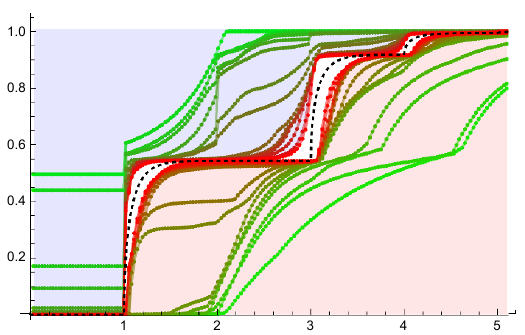
Figure 8 . Bounds on the modular spectral function with no scalar primaries in the spectrum and a dimension gap of (cid:1) gap = c (cid:0) 13 for c = 25. The dotted black curve denotes the extremal modular 12 spectral function